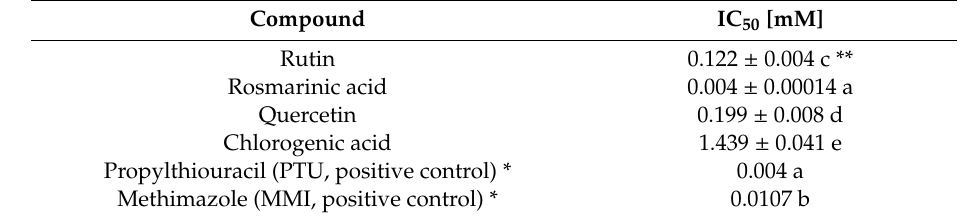
Table 3. IC 50 [ µ M] value of polyphenols showing inhibitory e ff ect on TPO activity used in the study, n =